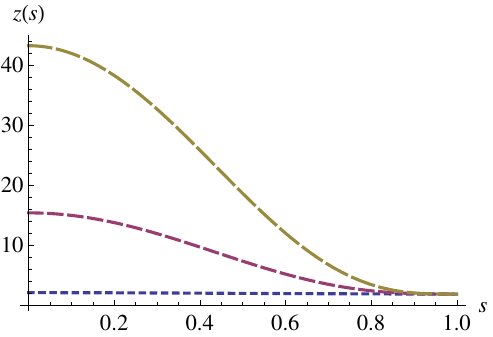
Figure 18. Density distribution for a stellar fragment (with temperature θ = 0.824) as a function of the distance from the center, s , for several values of the fragment’s radius a : a = 0.05 (the lower line), a = 0.1, and a = 0.12 (the upper